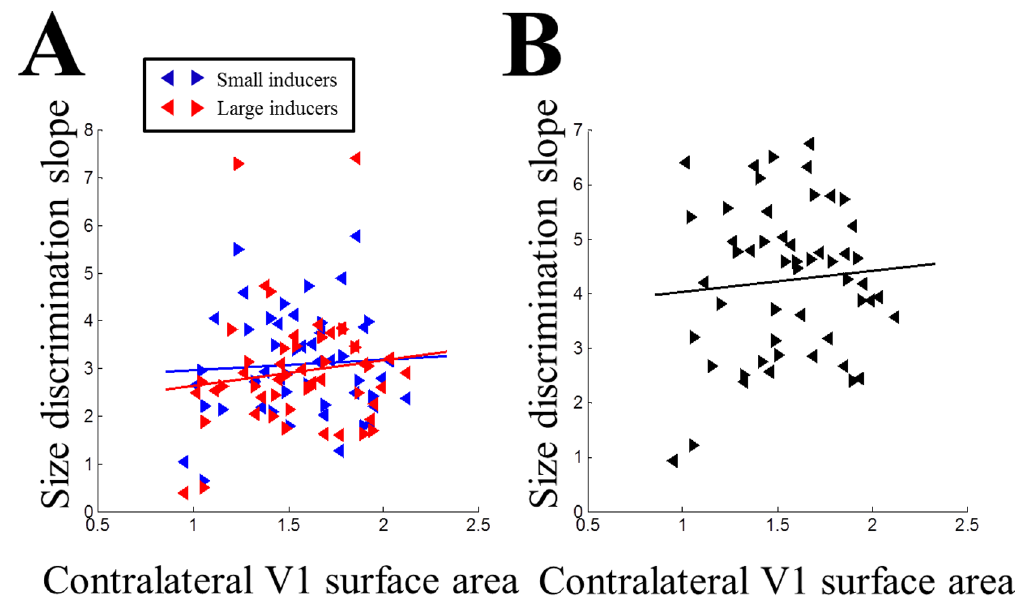
Figure 4. Size discrimination and V1 surface area. A. Individual discrimination slopes plotted against the surface area of contralateral V1 (expressed as percentage of the cortical hemisphere). Blue: small inducers. Red: large inducers. B. Individual discrimination slopes for the control stimulus (without any inducers) plotted against contralateral V1 surface area. In both plots, left and right pointing triangles denote measurements from left and right visual hemifields in individual participants, respectively. Solid lines are linear regression